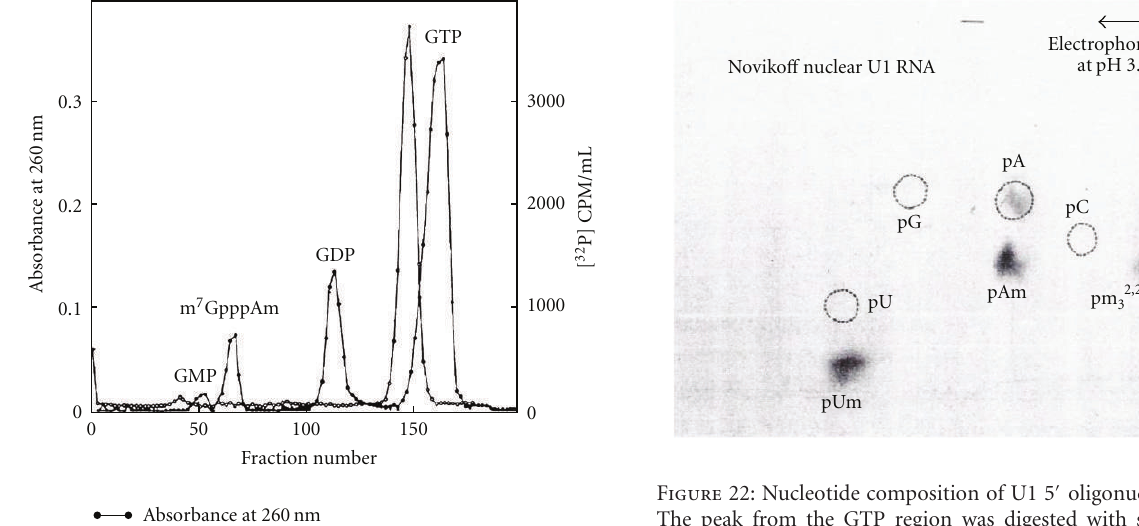
(H/ACA snoRNA) or 2 (cid:2) -O-methylation (C/D